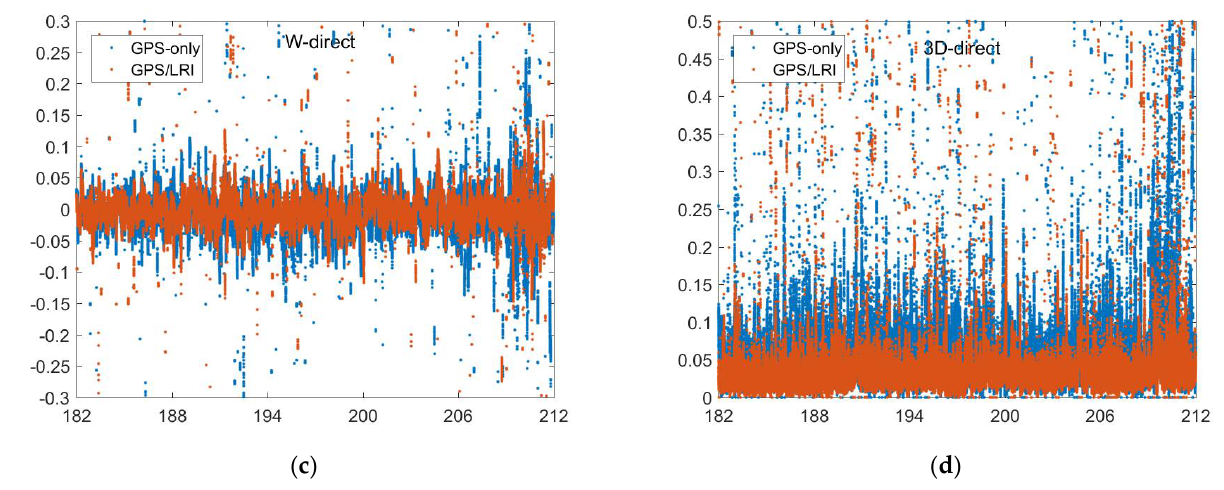
Figure 9. Reference orbit check for GRACE-FO-A in the R, S, W, 3D directions (days 182-212, ( a – d )).